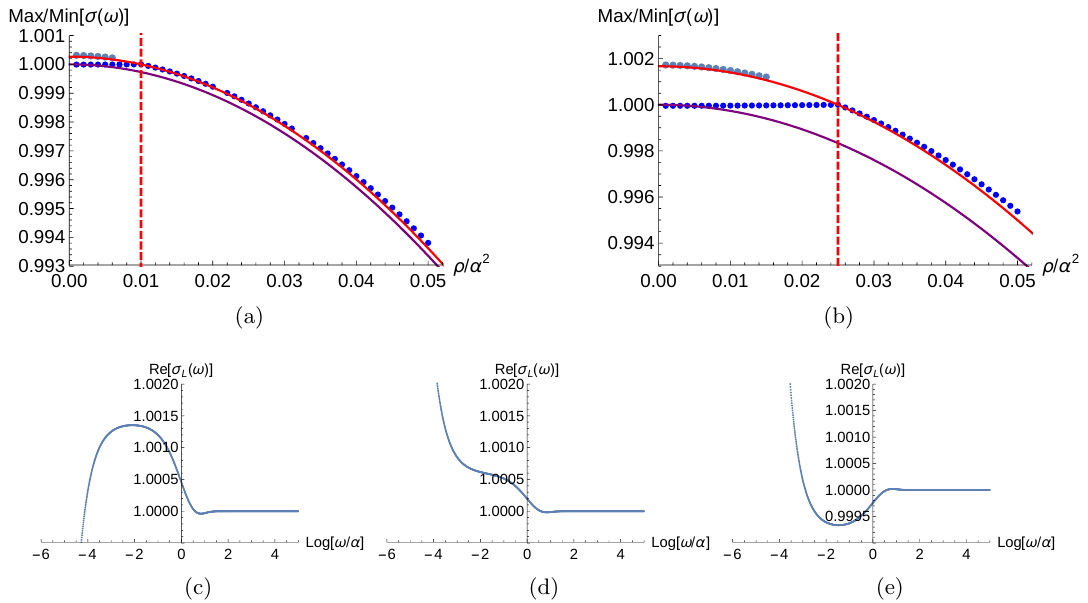
Figure 3 : Turning points of the AC charge conductivity as a function of charge density for two values of the magnetic (cid:12)eld: B=(cid:11) 2 = 0 : 01 (top left) and B=(cid:11) 2 = 0 : 025 (top right). The blue dots are data while the solid red line is our analytic result for the incoherent conductivity (cid:27) . The dashed red line indicates the point where (cid:26) = B while the purple 0 line indicates the B = 0 limit of our analytic result, coinciding with the conductivity given by [15]. In particular, the light blue uppermost dots of both (cid:12)gures which occur in the region B > (cid:26) are maxima, while the dark blue dots in the region (cid:26) > B are minima. In the bottom row we display a zoomed in plot of real part of the longitudinal charge conductivity against the logarithm of frequency at B=(cid:11) 2 = 0 : 025. The leftmost plot with (cid:26)=(cid:11) 2 = 1 = 100 such that B (cid:29) (cid:26) shows the local maximum at log !=(cid:11) (cid:25) (cid:0) 2 which corresponds to the light blue dots in the upper right (cid:12)gure. The rightmost plot is taken at (cid:26)=(cid:11) 2 = 3 = 100 so that (cid:26) > B and we have a minimum at log !=(cid:11) (cid:25) (cid:0) 1 : 5. The middle plot on the bottom row indicates what happens in the intermediate region (cid:26) . B